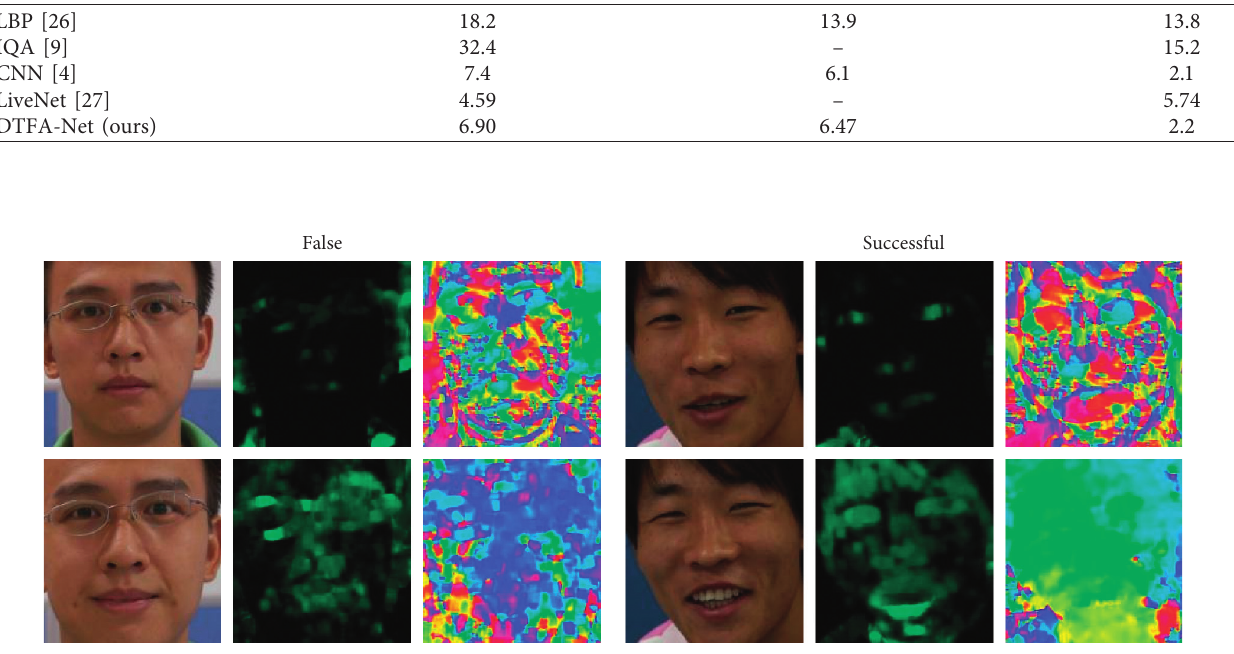
Figure 13: The false and right detection samples. Left: false-negative result; right: true-positive